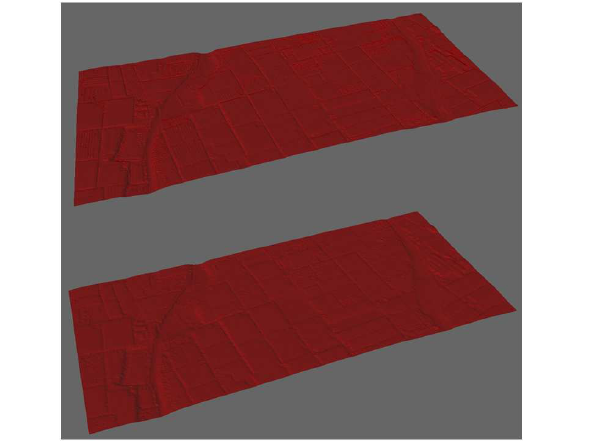
Figure 4. 3D shaded view of GMRF DSM (1 m grid spacing). Top: ratio of observed points 90% (high density); σ p = 1 m. Bottom: ratio of observed points 10% (low density); σ p = 4 m